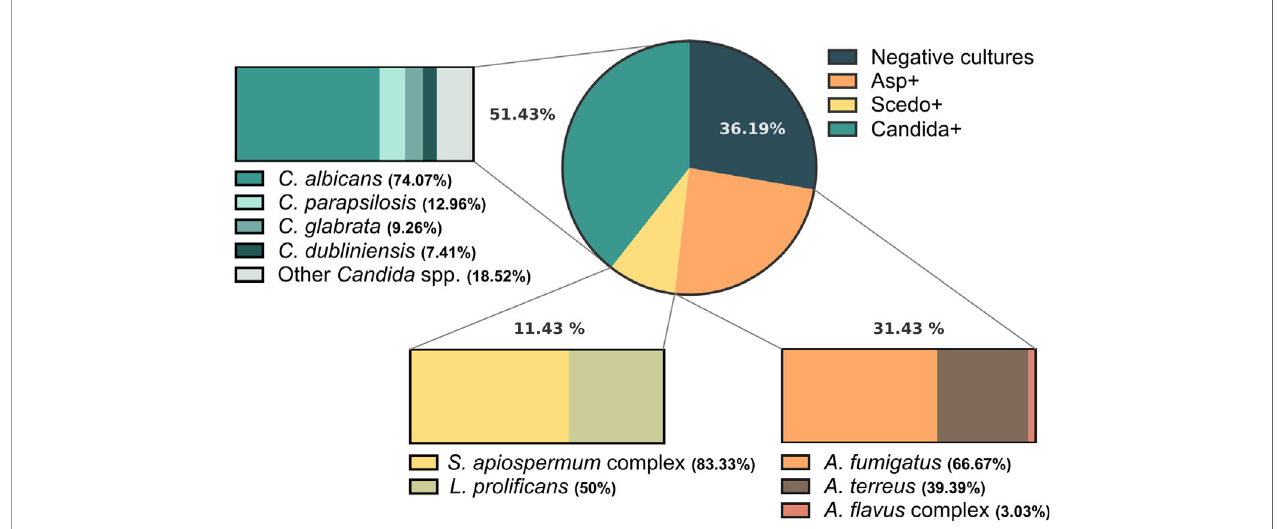
FIGURE 2 | Frequency of isolation of fungal species from respiratory samples of Cystic Fibrosis (CF) patients when culturing sputum samples on Sabouraud gentamicin chloramphenicol agar and Modi fi ed Thayer Martin agar or Sabouraud chloramphenicol cycloheximide agar for the selective recovery of Scedosporium species from these polymicrobial samples. The circle depicts the general prevalence of Aspergillus spp., Scedosporium / Lomentospora and Candida spp., as well as the frequency of patients with negative cultures for these fungi: 31.43%, 11.43%, 51.43%, and 36.19%, respectively. Moreover, the species-speci fi c prevalence is represented within the